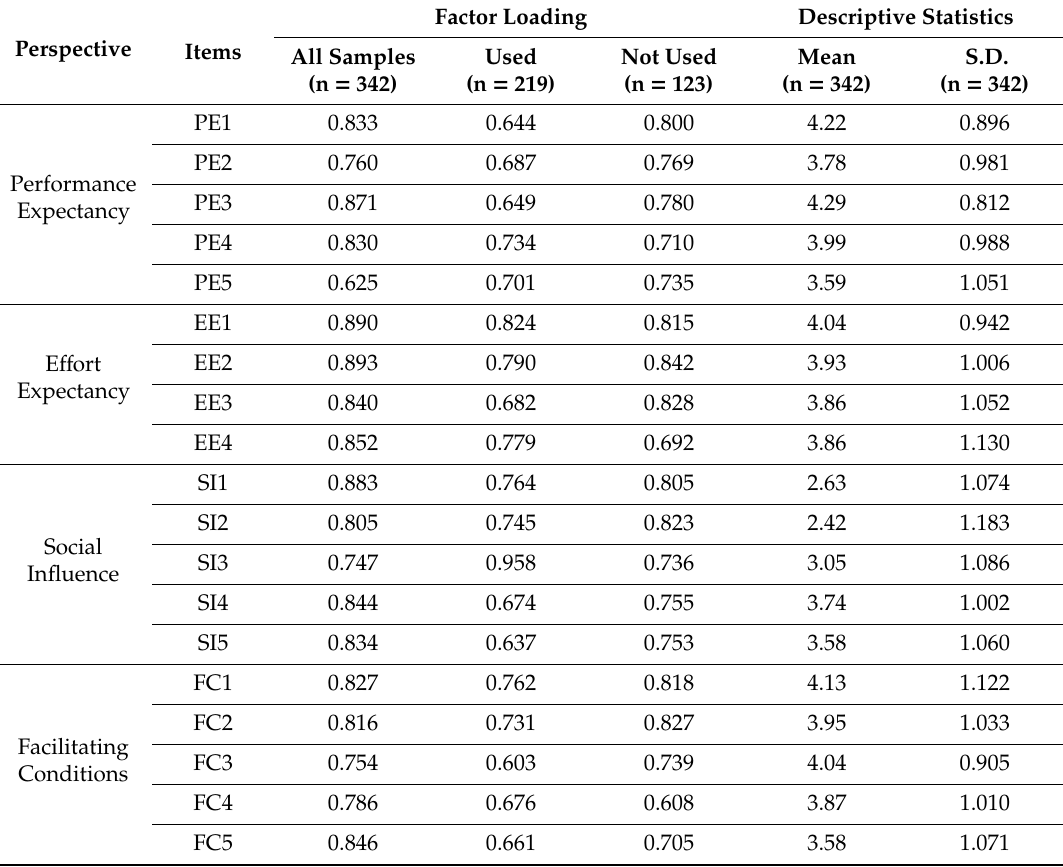
Table 3. Perspective validity analysis and descriptive